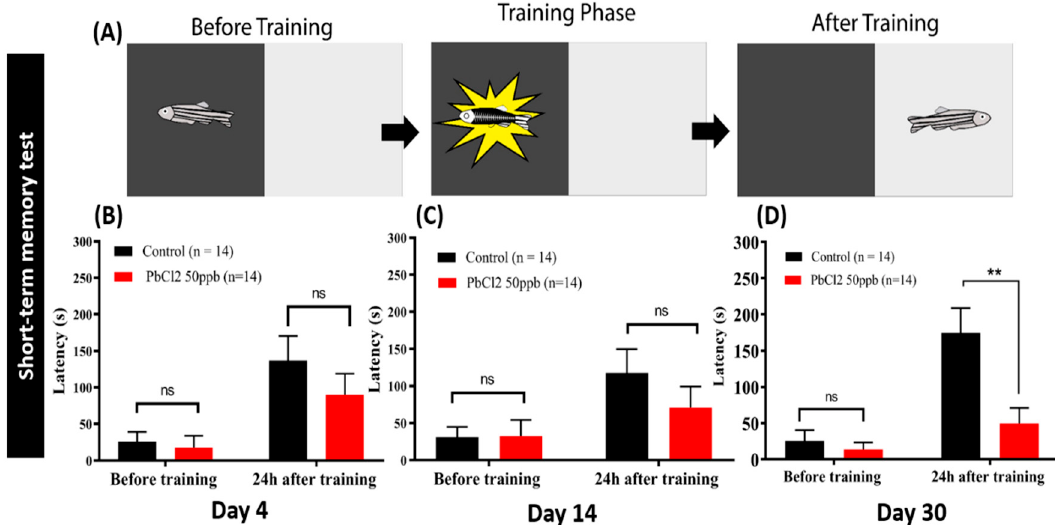
Figure 7. Passive avoidance task to test the short-term memory of fish treated with different exposure durations in 50 ppb of PbCl 2 . ( A ) An illustration that shows the principle of the shuttle box experiment. Twenty-four hours after the training session, we tested the latency for the fish to enter the dark compartment equipped with an electrical shock. Latency of fish treated with PbCl 2 (50 ppb) after 4 days ( B ), 14 days ( C ), and 30 days ( D ) after training. Data are expressed as mean ± SEM values and analyzed by two-way ANOVA ( n = 10; ** p ≤ 0.01).